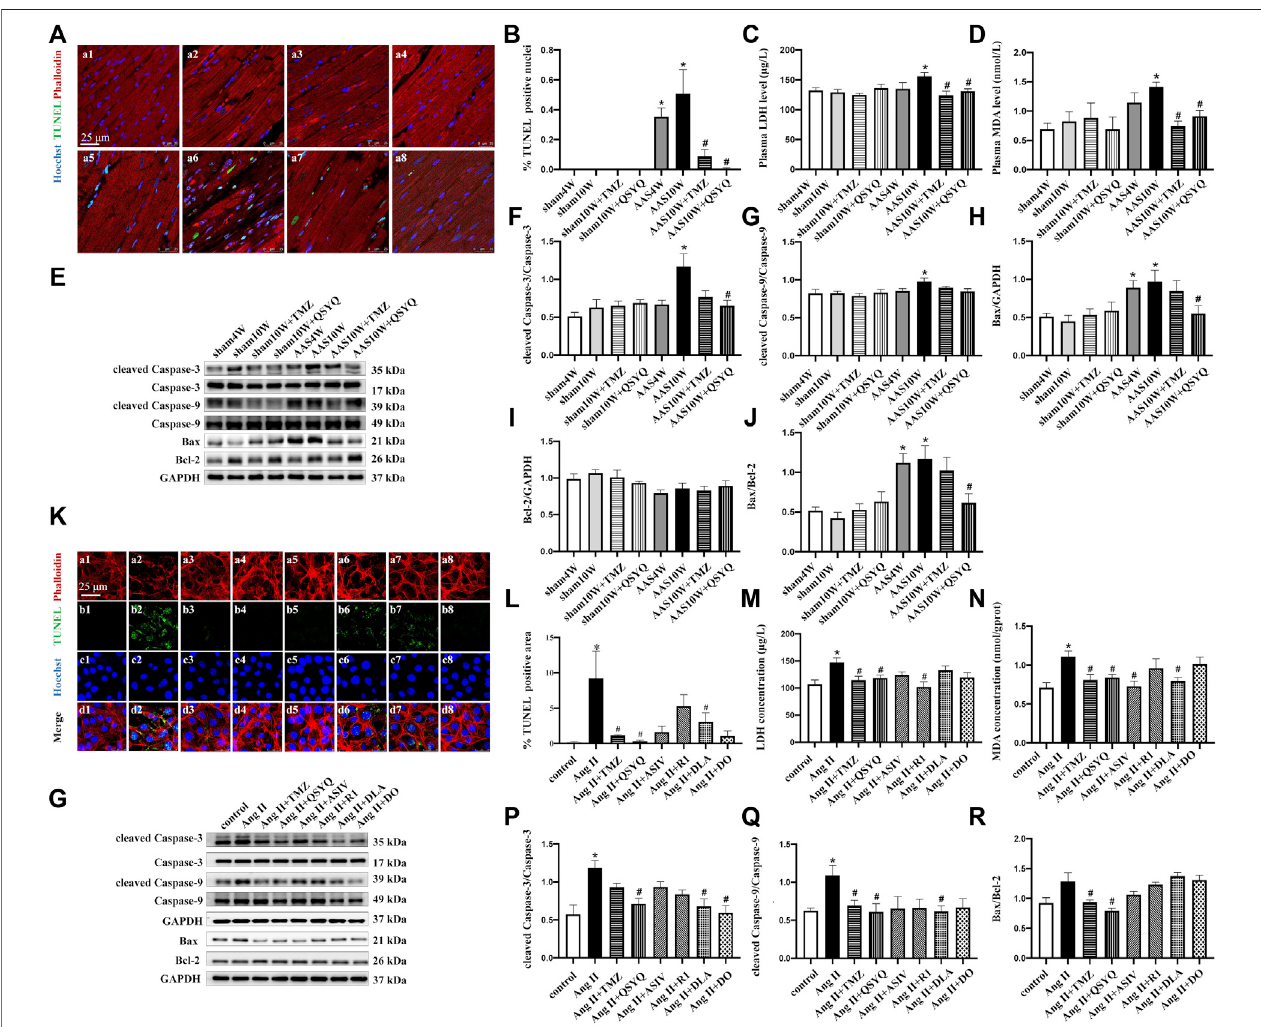
FIGURE2| Effects ofQSYQ and itsmain ingredients on cardiomyocyteapoptosisboth in vivo and in vitro . (A) TUNEL stainingofratheartsections inthe Sham4W (a1), Sham10W (a2), Sham10W + TMZ (a3), Sham10W + QSYQ (a4), AAS4W (a5), AAS10W (a6), AAS10W + TMZ (a7), and AAS10W + TMZ (a8) groups. Scale bar = 25 μ m. (B) Quanti fi cation result ofTUNEL-positive cardiomyocytes inrat hearts. Data arepresentedasthe mean ±SEM, n =3. (C) Serum lactate dehydrogenase (LDH) leveldetectedbyELISAindifferentgroups. (D) Serummalondialdehyde(MDA)leveldetectedbyELISAinthedifferentgroups. (E) Westernblotofapoptosis-related proteins:cleavedcaspase-3/caspase-3,cleavedcaspase-9/caspase-9,Bax,Bcl-2,andBax/Bcl-2. (F – J) Quanti fi cationanalysesoftheWesternblotresultsforcleaved caspase-3/caspase-3, cleaved caspase-9/caspase-9, Bax, Bcl-2, and Bax/Bcl-2. Data are presented as the mean ± SEM. n = 4. (K) TUNEL and phalloidin staining of H9C2 cells inthe control (a1, b1, c1, and d1), Ang II(a2, b2, c2, and d2), Ang II+ TMZ (a3, b3, c3, and d3), Ang II+ QSYQ (a4, b4, c4, and d4), Ang II+ASIV (a5, b5, c5, and d5),AngII+R1(a6, b6,c6,and d6),AngII+DLA(a7, b7,c7,and d7),andAng II+DO(a8,b8, c8,andd8)groups. Bar=25 μ m. (L) Quanti fi cation resultofTUNEL- positive cells. Data are presented as the mean ± SEM, n = 3. (M) Lactate dehydrogenase (LDH) level detected in supernatants of H9C2 cells by ELISA. (N) Malondialdehyde (MDA) level detected in H9C2 cell lysates by ELSA. Data are presented as the mean ± SEM, n = 4. (O) Western blot of apoptosis-related proteins in H9C2 cells fromthe differentgroups: cleaved caspase-3/caspase-3, cleaved caspase-9/caspase-9, Bax,and Bcl-2. (P – R) Quanti fi cation ofthe Western blotresults for cleavedcaspase3/caspase3,cleavedcaspase-9/caspase9,andBax/Bcl-2inH9C2cellsfromthedifferentgroups.Dataarepresentedasthemean±SEM, n =4.* p < 0.05 vs. control; # p < 0.05 vs. Ang